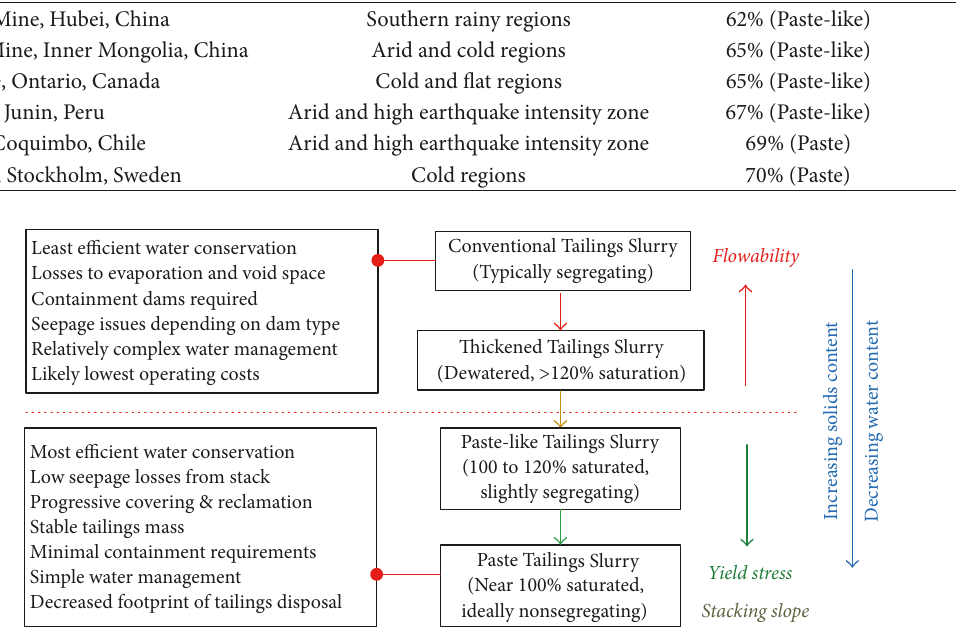
Figure 1: Comparison of different tailings surface disposal